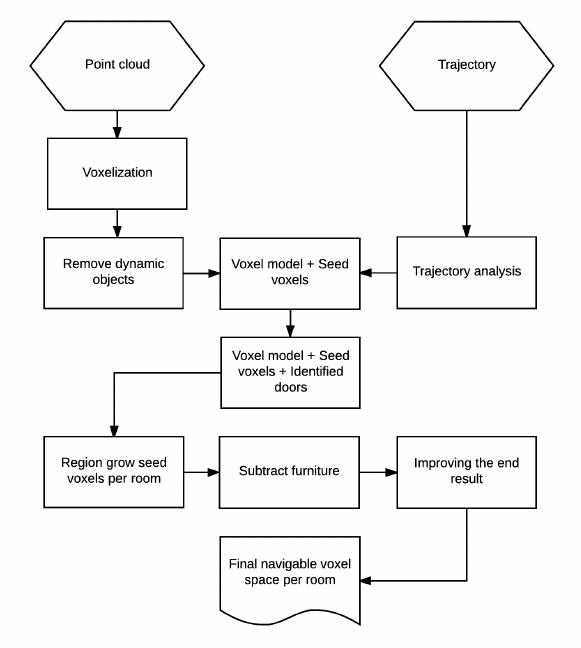
Figure 1. Overview of the proposed